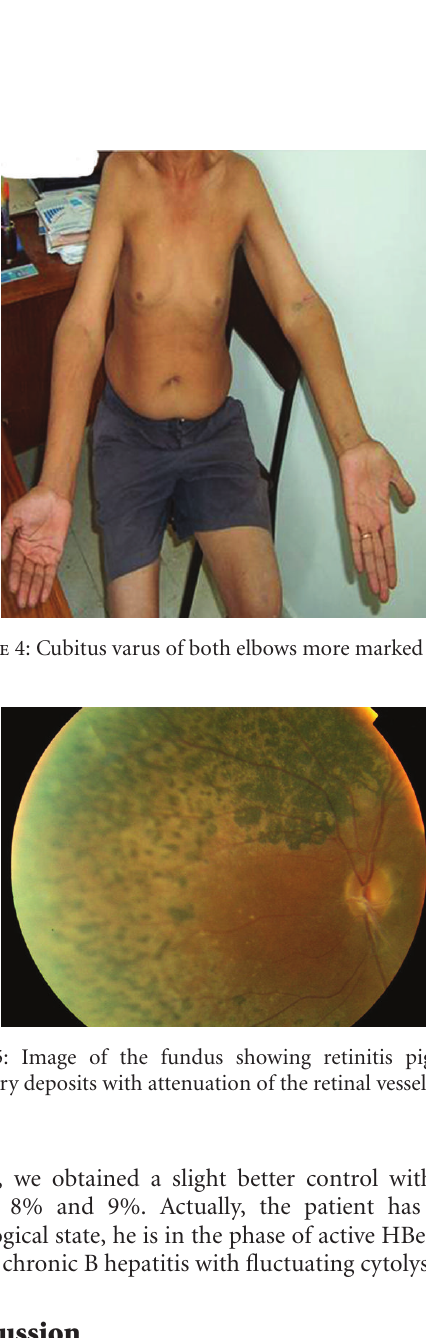
right kidney on abdominal ultrasound, computed tomog- raphy and Tc-99m methylene diphosphonate scintigraphy